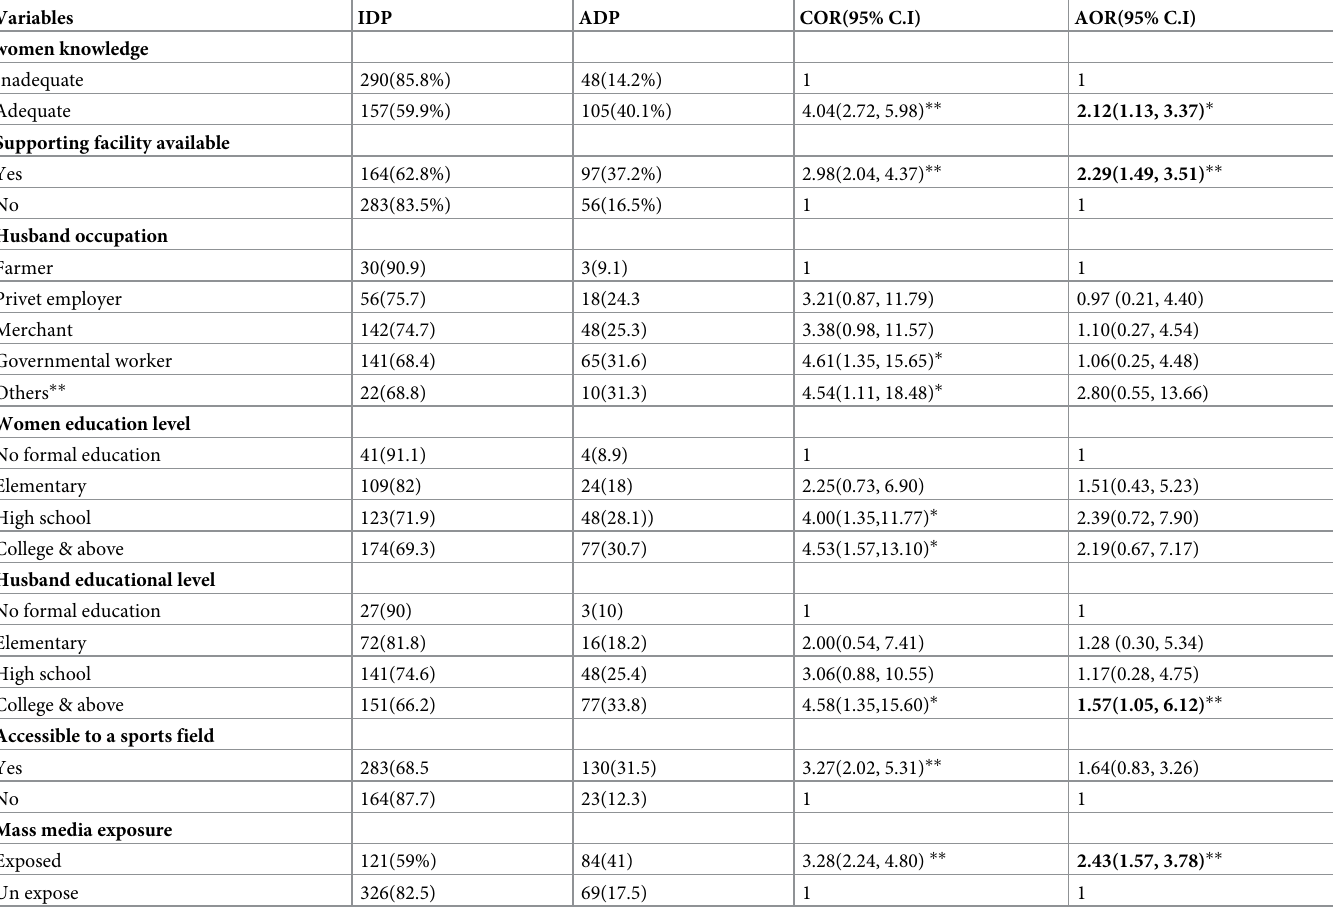
Table 9. Bivariate and multivariate analysis of factors associated with women’s practice of antenatal physical exercise during pregnancy among pregnant women in Hawassa city, Southern Ethiopia,